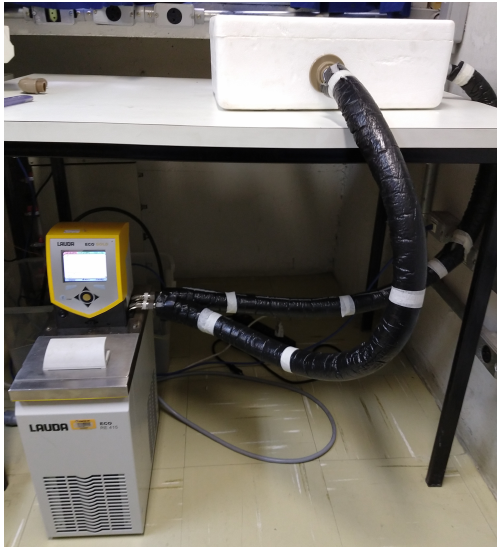
Figure 1. Experimental apparatus used in the tests to determine the temperature dependence of the sound speed. The setup consists of a thermostatic bath, capable of promoting the external flow of temperature-controlled fluid, and a container where the thermal exchange